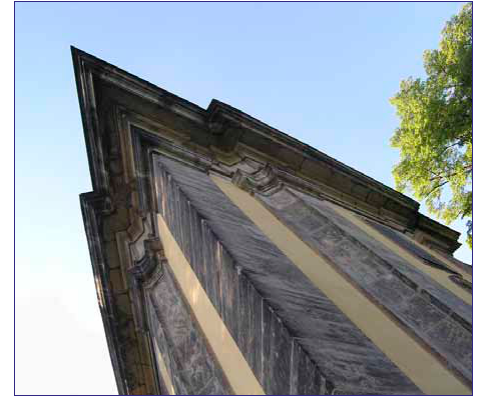
fig. 6. Chlumec u Chabařovic (Kulm), Holy Trinity chapel na Horce, 1690–1691. Corner detail. Photo: